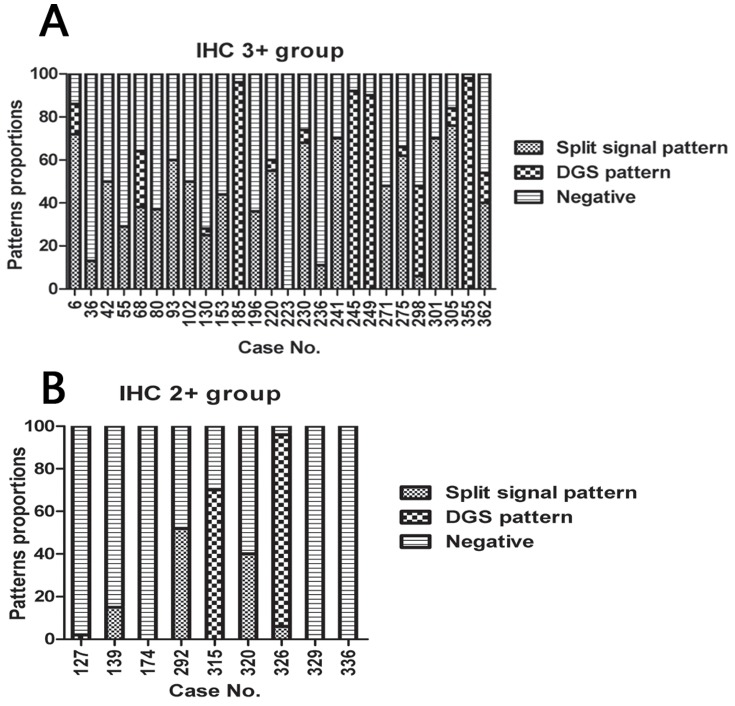
Patterns proportions of split signal pattern as positive cell, deleted green signal (DGS) pattern as positive cell, and negative cell of each case detected by FISH in ALK IHC 3+ group (A) and 2+ group (B).